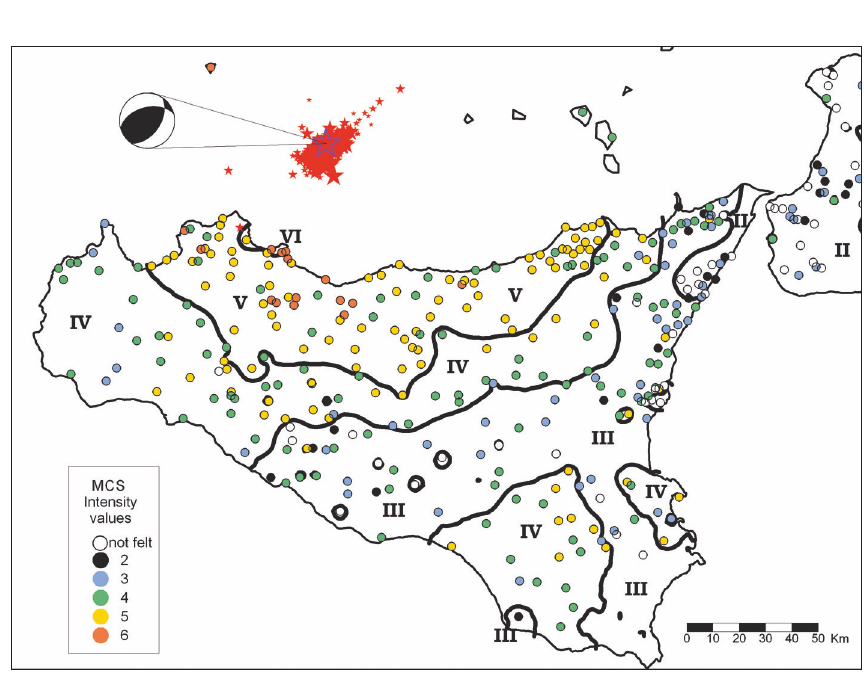
Fig. 1. Macroseismic data of September 6, 2002 event with smoothed and interpolated field reconstruction (black isoseismals). Original intensity values are represented by color dots, while epicenters of the sequence are identified by red